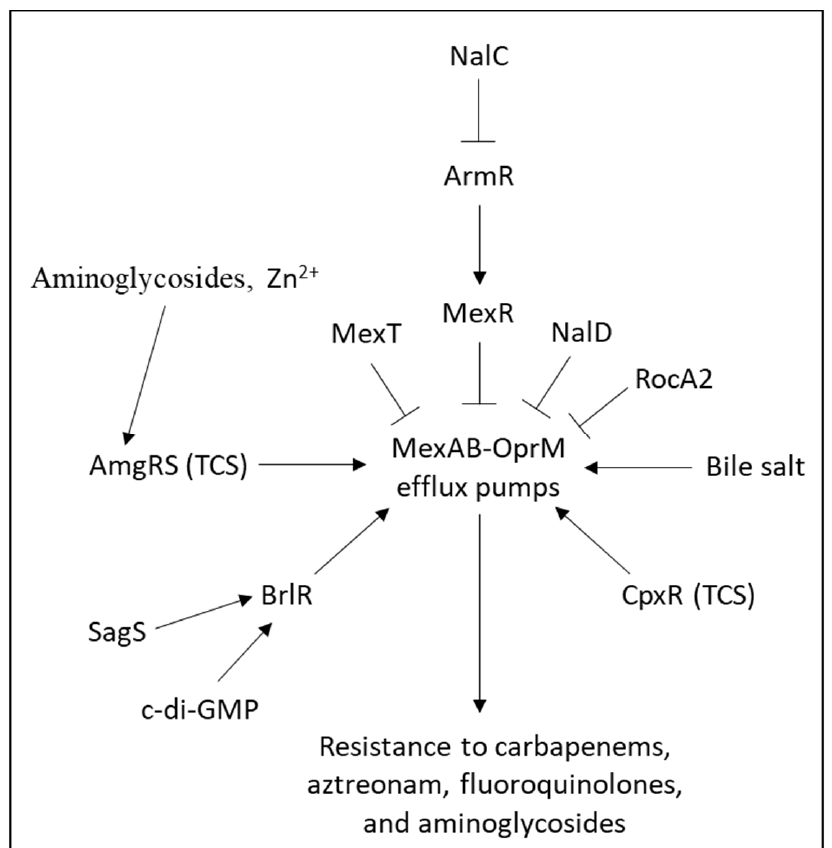
Figure 6. Regulation of MexAB-OprM multidrug efflux pump expression in Pseudomonas aerug- inosa . The expression of the MexAB-OprM efflux pump is positively and negatively regulated by a whole range of transcriptional regulators. Its expression is also affected by bile salts and induced by the AmgRS TCS and CpxR, which is the cognate response regulator of the CpxAR TCS. The efflux pump MexHI-OpmD exports the toxic metabolite anthranilate that serves as a precursor of the autoinducer PQS [237]. Pseudomonas aeruginosa lacking a